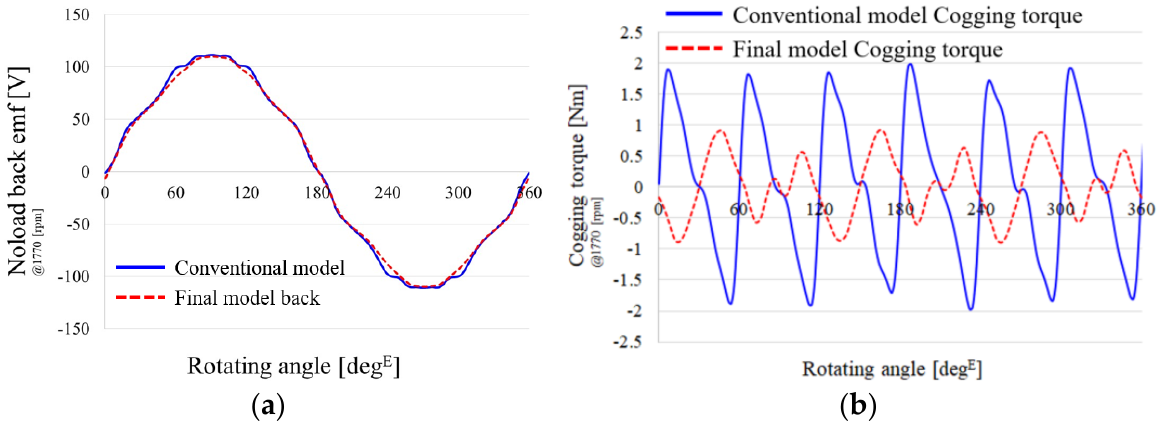
Figure 19. Noload back emf and cogging torque waveforms for conventional model and final model: ( a ) back emf waveform; ( b ) cogging torque waveform.